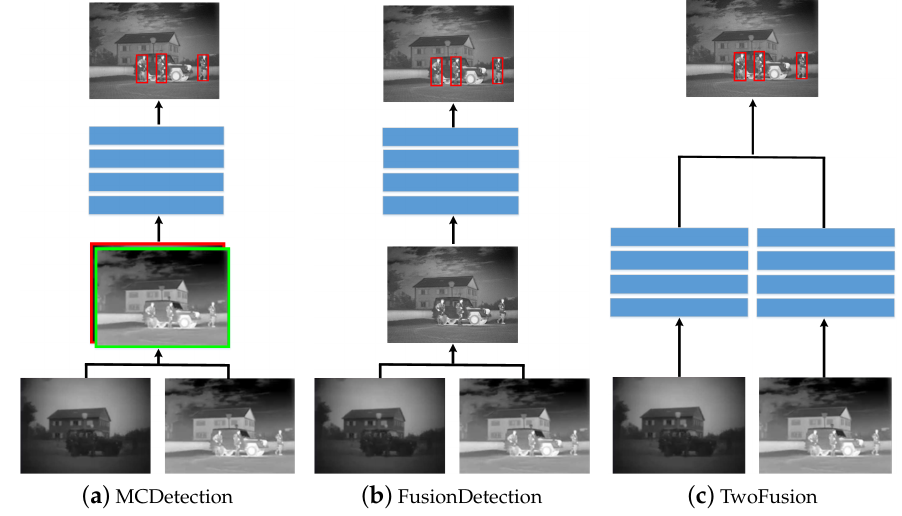
Figure 7. ( a – c ) The pipelines for MCDetection, FusionDetection, and TwoFusion. IAF R-CNN: As shown in Figure 8b, IAF R-CNN [9] discovers that the